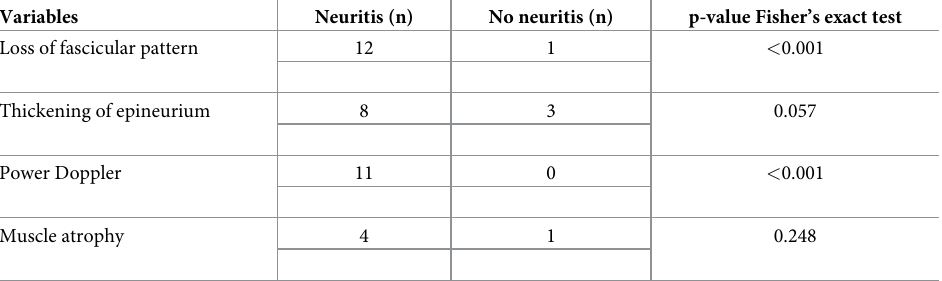
Table 4. Values of the area of the ulnar nerve at the level of the medial epicondyle (ulnar groove) and 2 cm proxi- mal to this, between groups with and without neuritis as determined by the reference criteria. Mann-Whitney test. Groups Epicondylar level (CSA) With neuritis